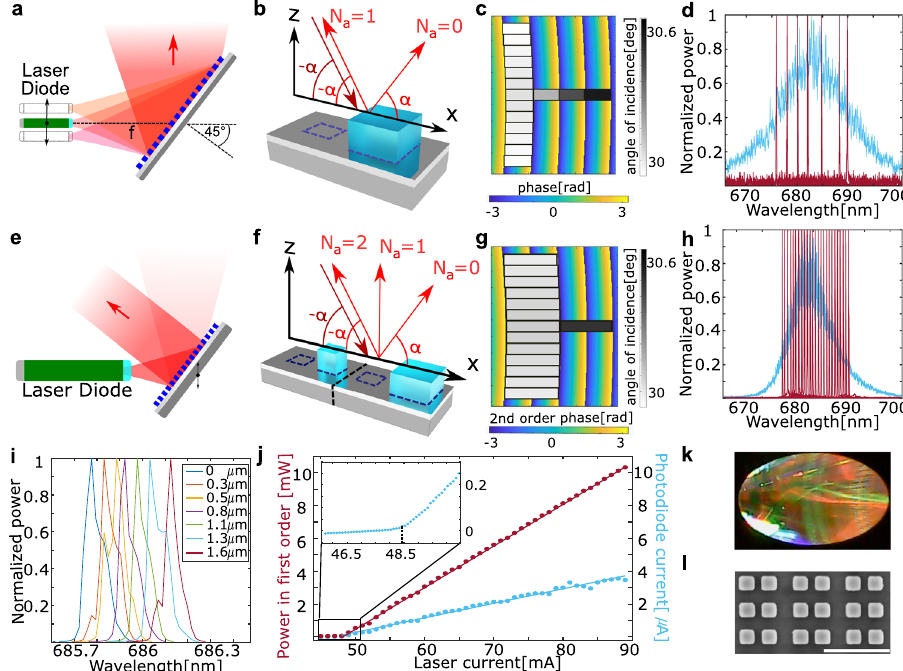
Fig. 3 Metasurface based external cavity laser (MECL) with diverging (a – d) and collimated output (e – l). a Schematic of the basic MECL: a re fl ective metalens focuses a narrow wavelength range back on the diode facet. Changing the position of the metasurface with respect to the laser diode controls the output wavelength. b Schematic of a supercell containing one optical element. The angle of the fi rst local diffraction order of each supercell matches the angle of incidence. c Schematic showing how the supercells (represented by rectangles) are positioned in order to create the desired phase pro fi le in the fi rst order. d Wavelength tuning for a drive current I = 75mA (red) and electroluminescence spectrum for I = 40mA (blue). Central wavelength = 685nm. The achieved range corresponds to a metasurface vertical shift of 45 µ m. e Schematic of the MECL with collimated output. f The new supercell is formed by two adjacent supercells shown in Fig. 2b. The intensity and phase in the fi rst order can be controlled by creating asymmetries in these two cells (e.g., pillar size or displacement in opposite directions). g Schematic showing how the supercells sample the desired phase pro fi le in the second order. h Normalized spectra for coarse wavelength tuning (red) and electroluminescence spectrum (blue), both for I = 65mA. Central wavelength = 685nm. i Fine wavelength tuning for I = 65mA. Legend shows the vertical shift of the metasurface. j Characterization of the lasing threshold at central wavelength. k Optical picture of the metasurface. The metasurface major and minor axes are 5.8mm and 2.5mm, respectively. l SEM image of a metasurface detail, scale bar is 1 µ